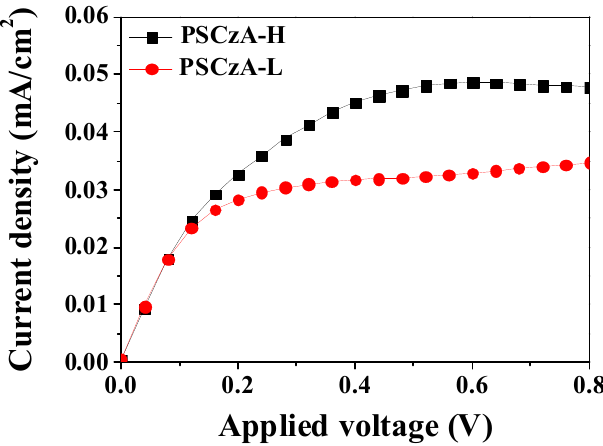
Figure 7. J – V characteristics of the additive-containing hole-only devices.